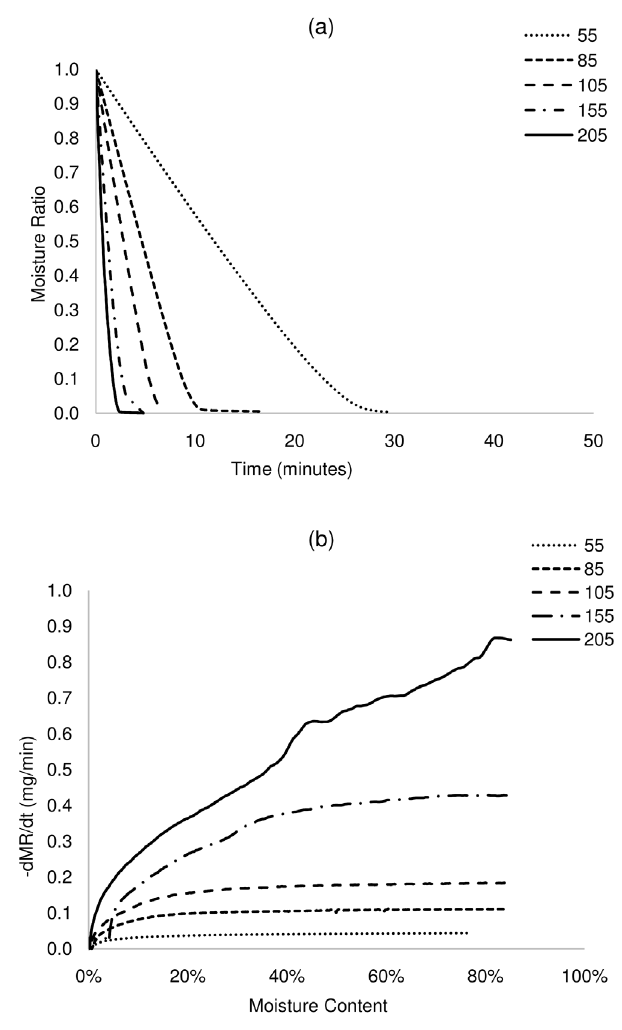
Figure 5. Isothermal drying curves of VIP at 55 – 205°C. a ) MR versus time, b ) drying rate versus moisture content. VIP, ventilated improved